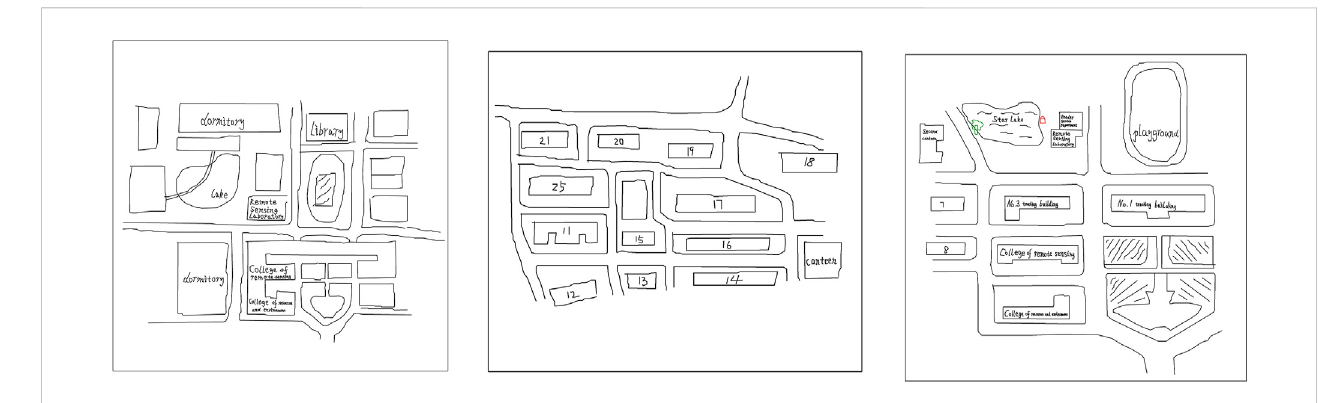
FIGURE 9 Experimental data